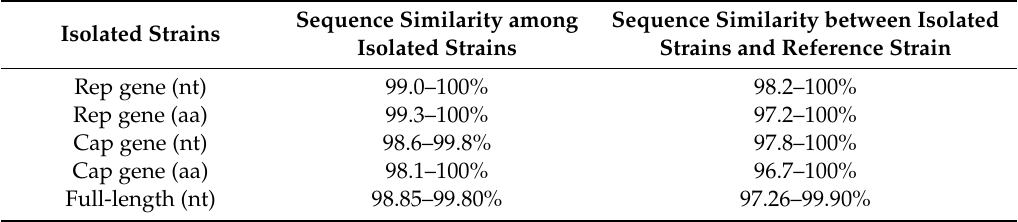
Table 2. Maximum nucleotide and amino acid sequence divergence of Porcine Circovirus 3 (PCV3).